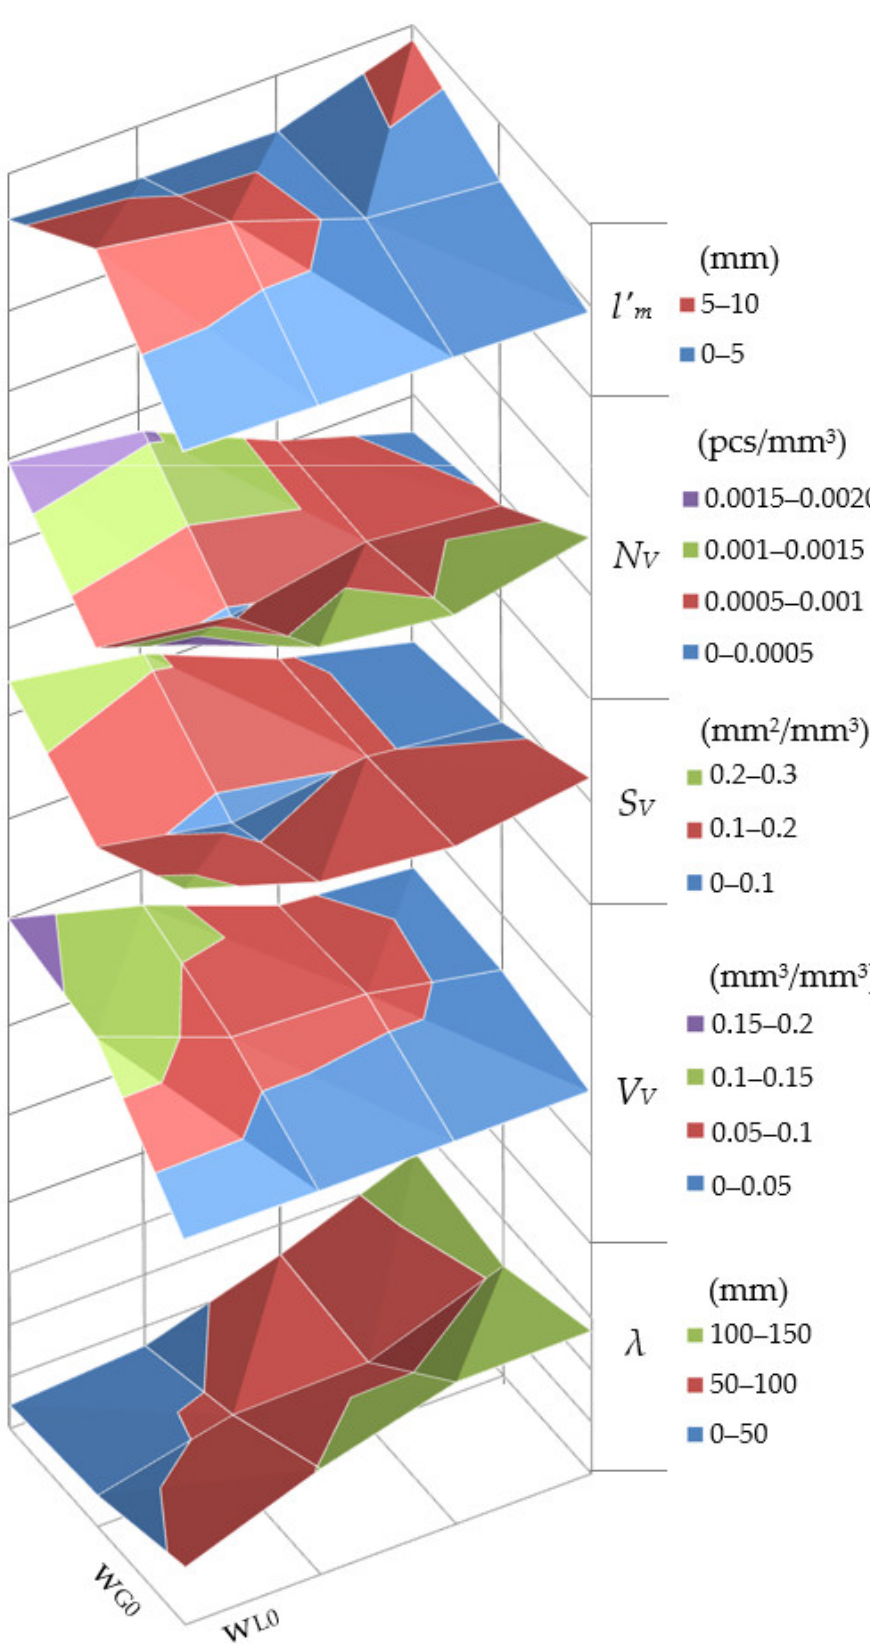
Figure 9. Plane graph of the variability of stereological parameters depending on phase